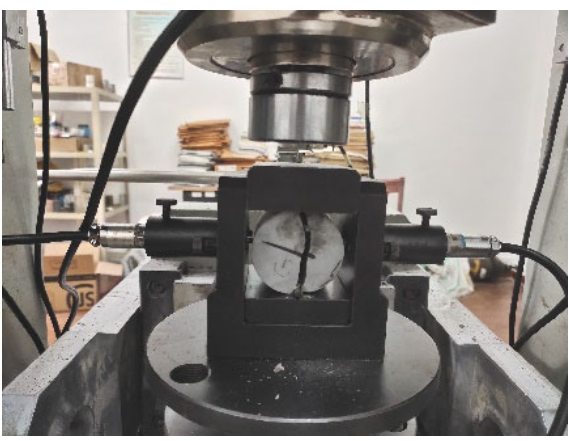
Figure 6. The splitting tensile strength experiment.